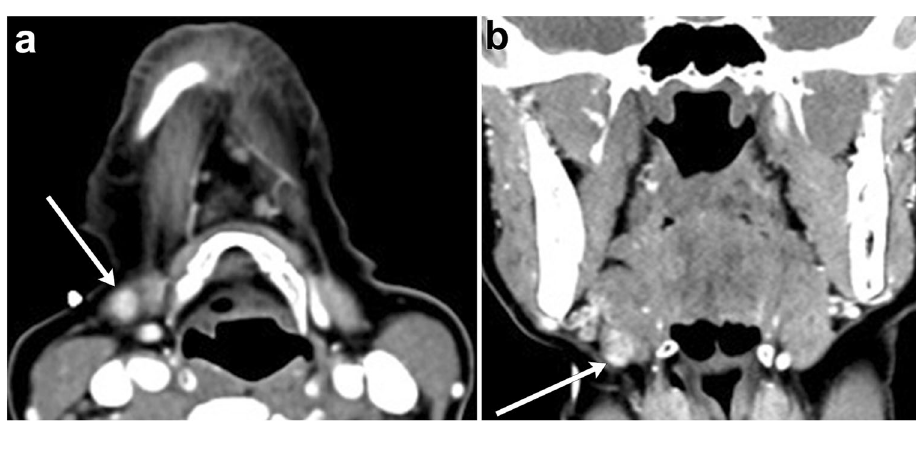
Fig. 13 Pleomorphic adenoma of the submandibular gland. a Axial and b coronal contrast-enhanced CT images demonstrate an enhancing well-circumscribed round mass within the inferior aspect of the right submandibular gland ( arrow